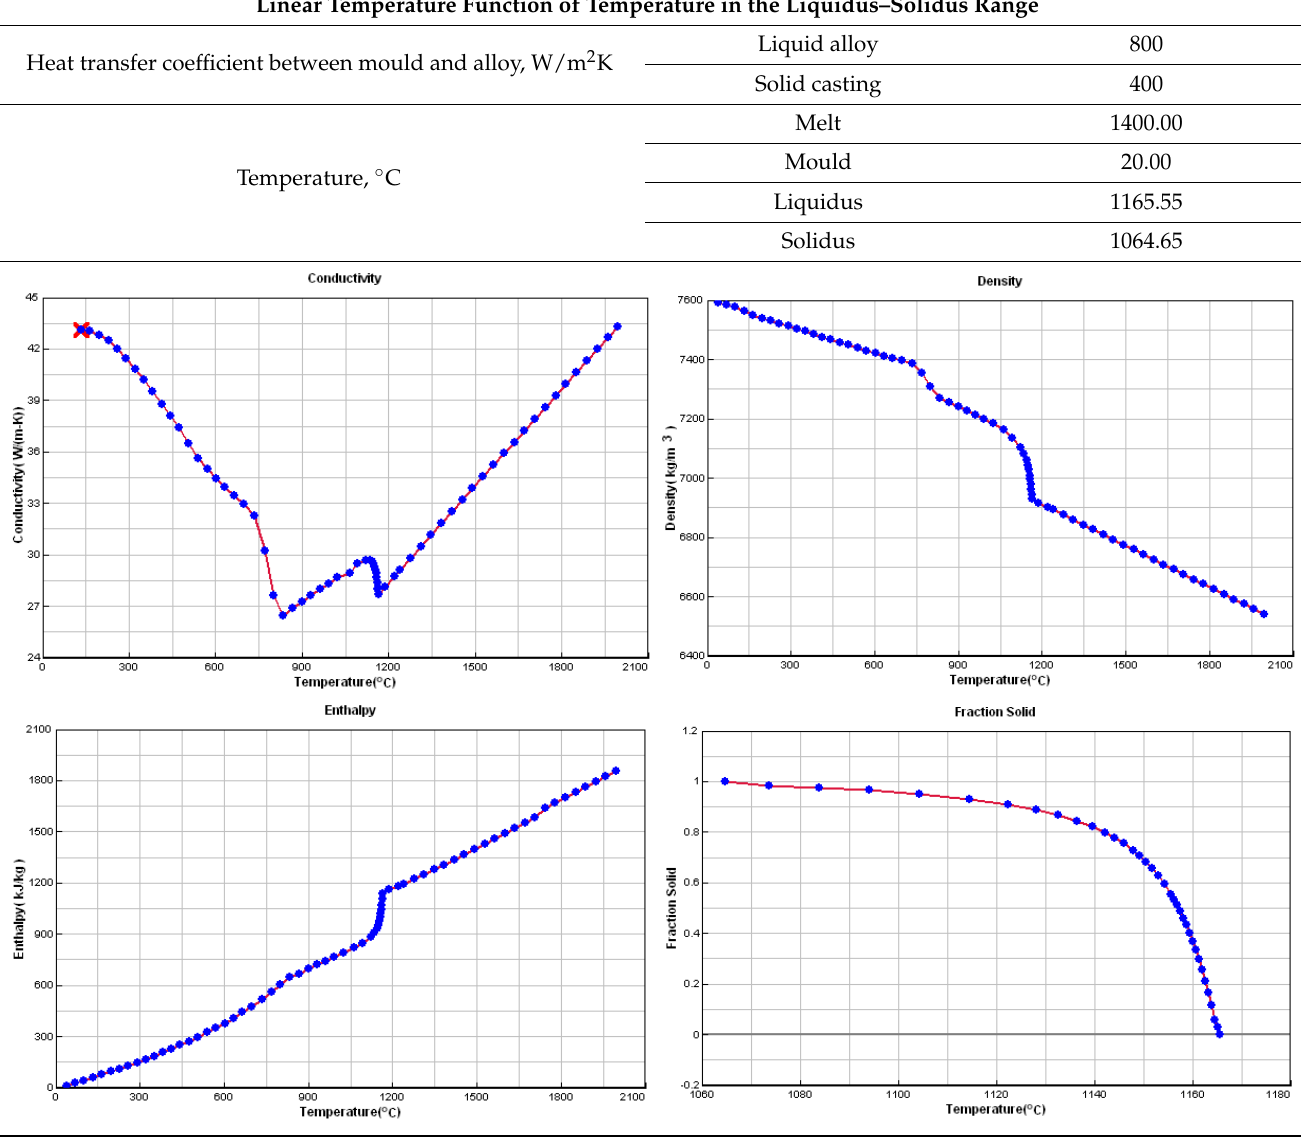
Table 5. Data used in the ProCAST simulation.